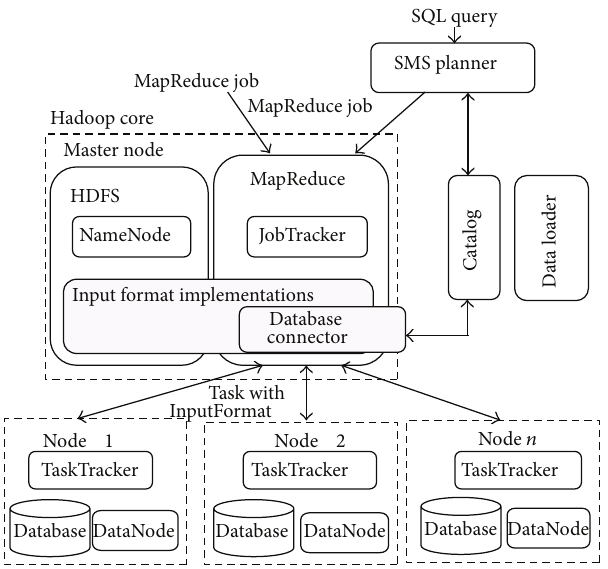
Figure 2: Architectures of HDFS and